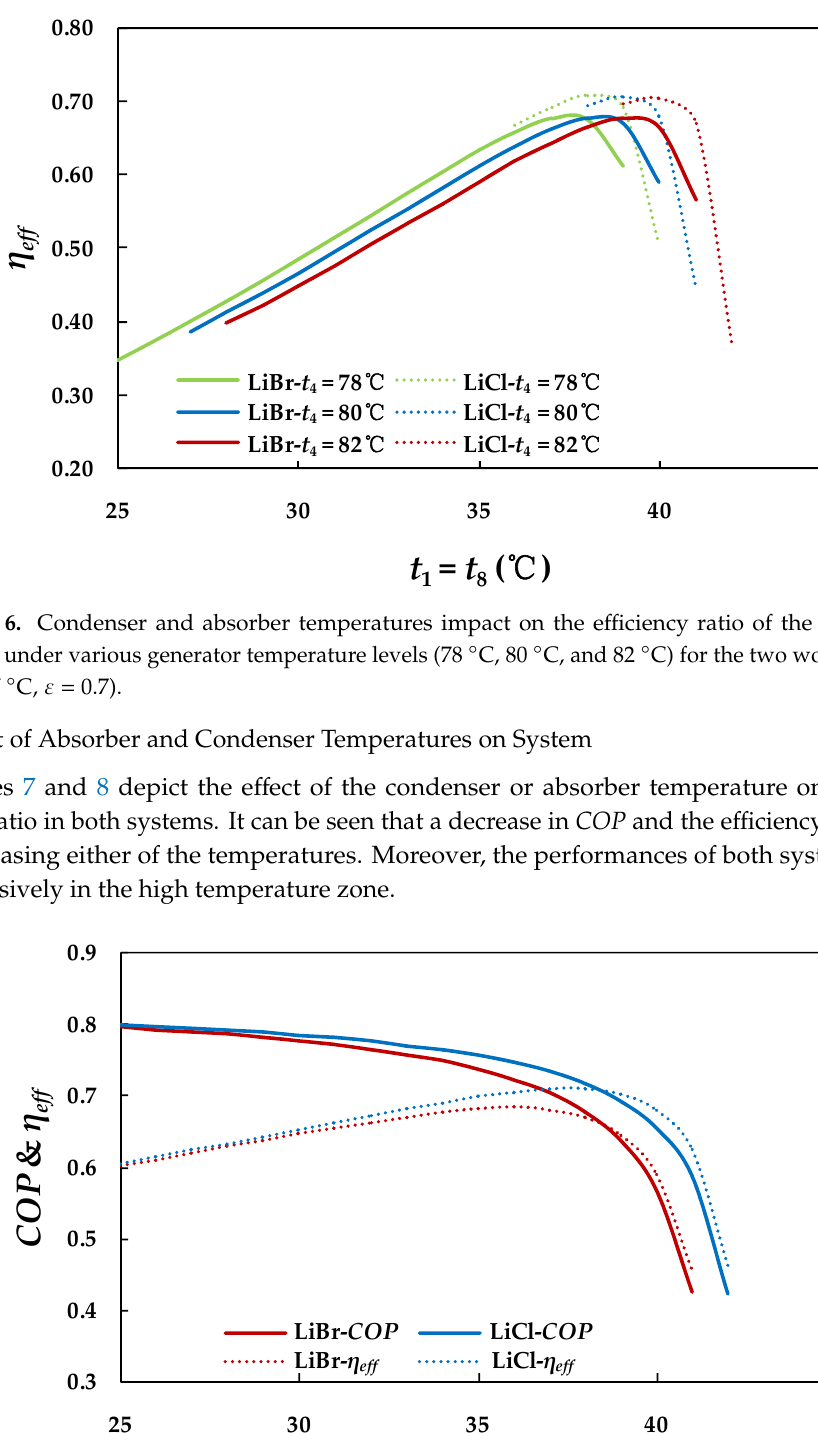
Figure 5. Condenser and absorber temperatures impact on the COP of the absorption system under various generator temperature levels (78 °C, 80 °C, and 82 °C) for the two working pairs ( t 10 = 7 °C, ε = 0.7).